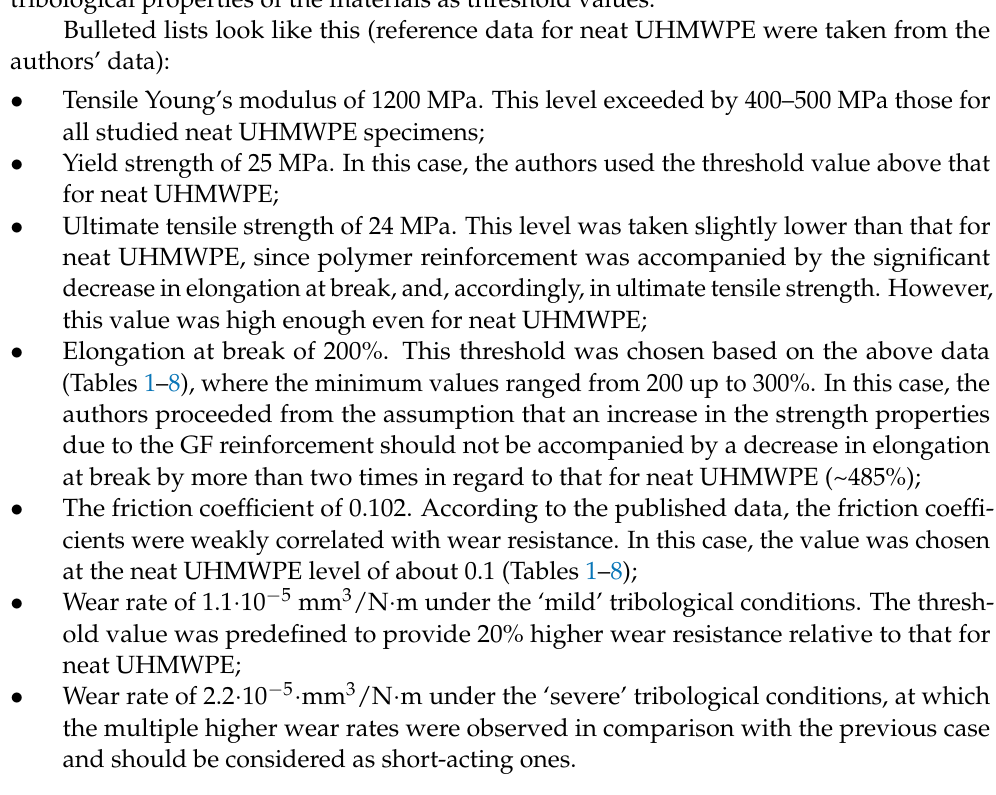
Table 16. The properties of the ‘Werkstoff’S (cid:48) ® PE 1000 ‘S (cid:48) ’ material fabricated by ‘Murtfeldt Kunst- stoffe GmbH & Co. KG’ [60]. Properties Test Method Values Average molecular weight (10 6 g/mol) - ~5 Density (g/cm 3 ) [52] 0.93 Water absorption (%) [53] <0.01 Yield strength / Ultimate tensile strength, MPa [54] ≥ 17/- Elongation at break (%) [54] ≥ 300 Tensile Young’s modulus (MPa) [54] 700 Charpy impact strength (unnotched) (kJ/m 2 ) [55] Without fracture Charpy impact strength (notched) (kJ/m 2 ) [55] ≥ 170 Ball indentation hardness (MPa) [61] 38 Shore D hardness [56] 66 The friction coefficient under dry friction conditions -